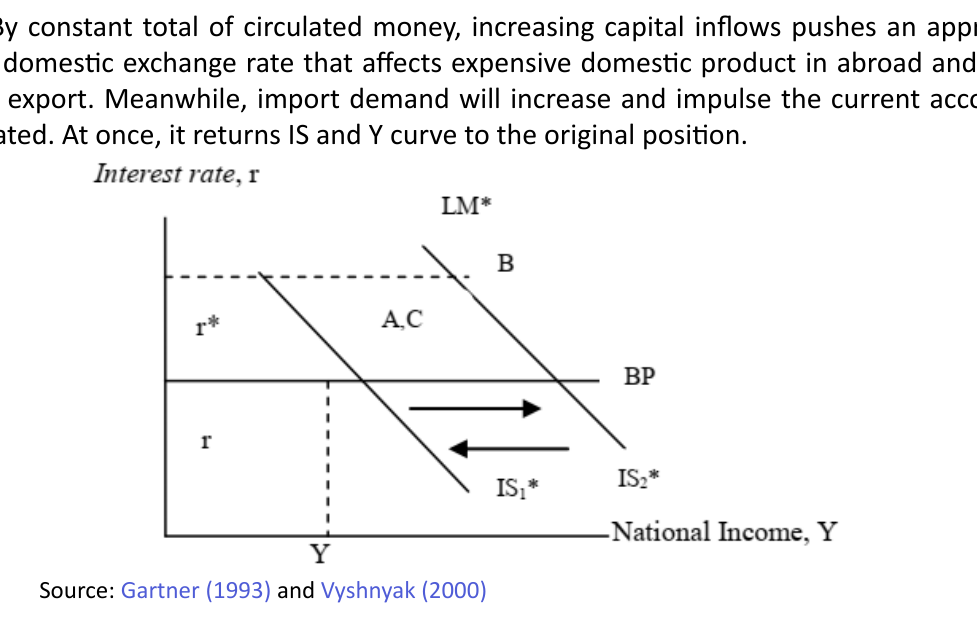
Figure 2: Fiscal expansion effect about National Income in float exchange rate